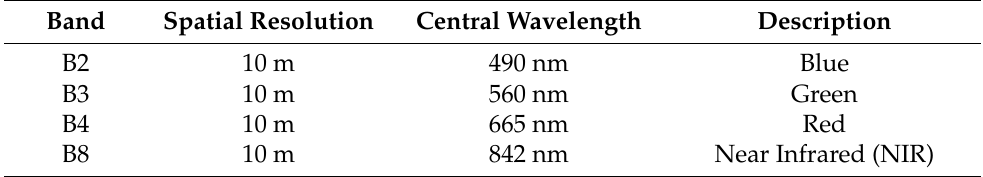
Table 1. S2 10 m